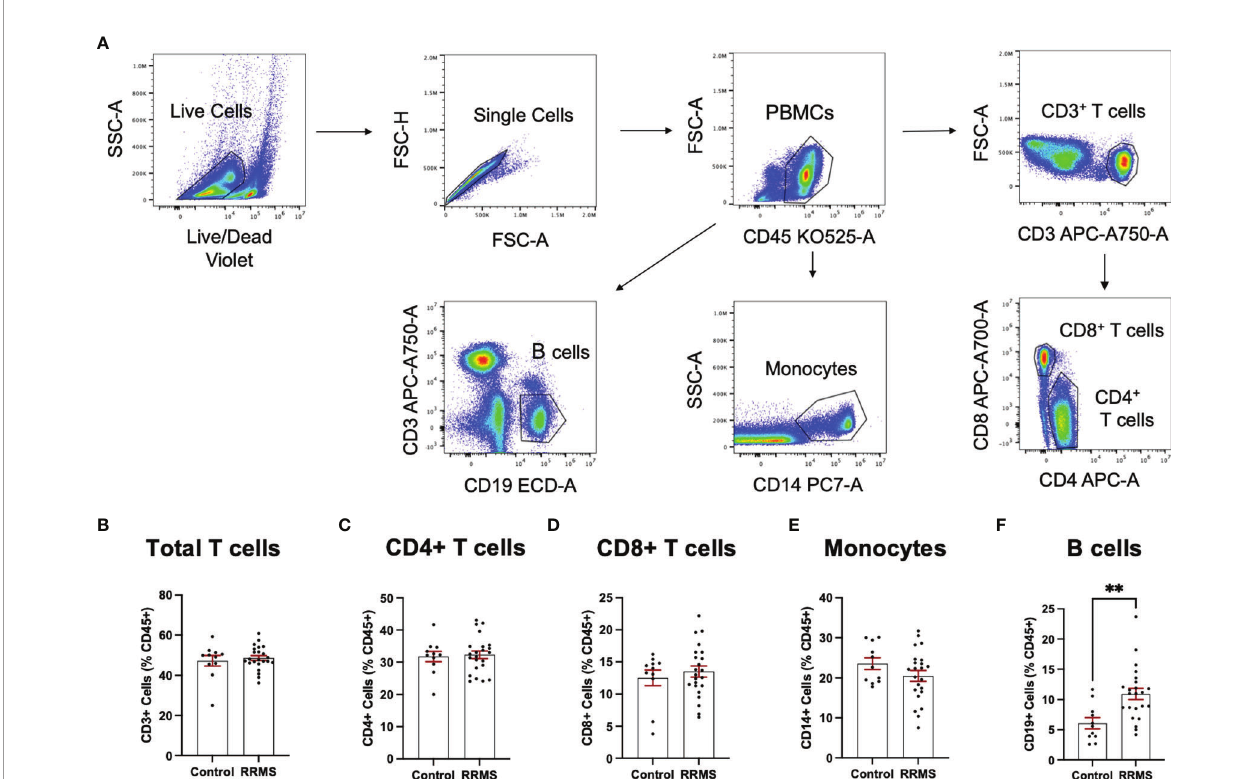
FIGURE 4 | Circulating PBMC immunophenotypes in RRMS and controls. (A) Representative fl ow cytometry plots display the PBMC gating strategy used to quantify levels of circulating lymphocyte populations. No signi fi cant differences in circulating (B) total T cells, (C) CD4+ T cells and monocytes, (D) CD8+ T cells or (E) monocytes were observed between RRMS and controls. (F) a signi fi cantly increased number of CD19 + cells were observed in RRMS patients compared to controls **p <